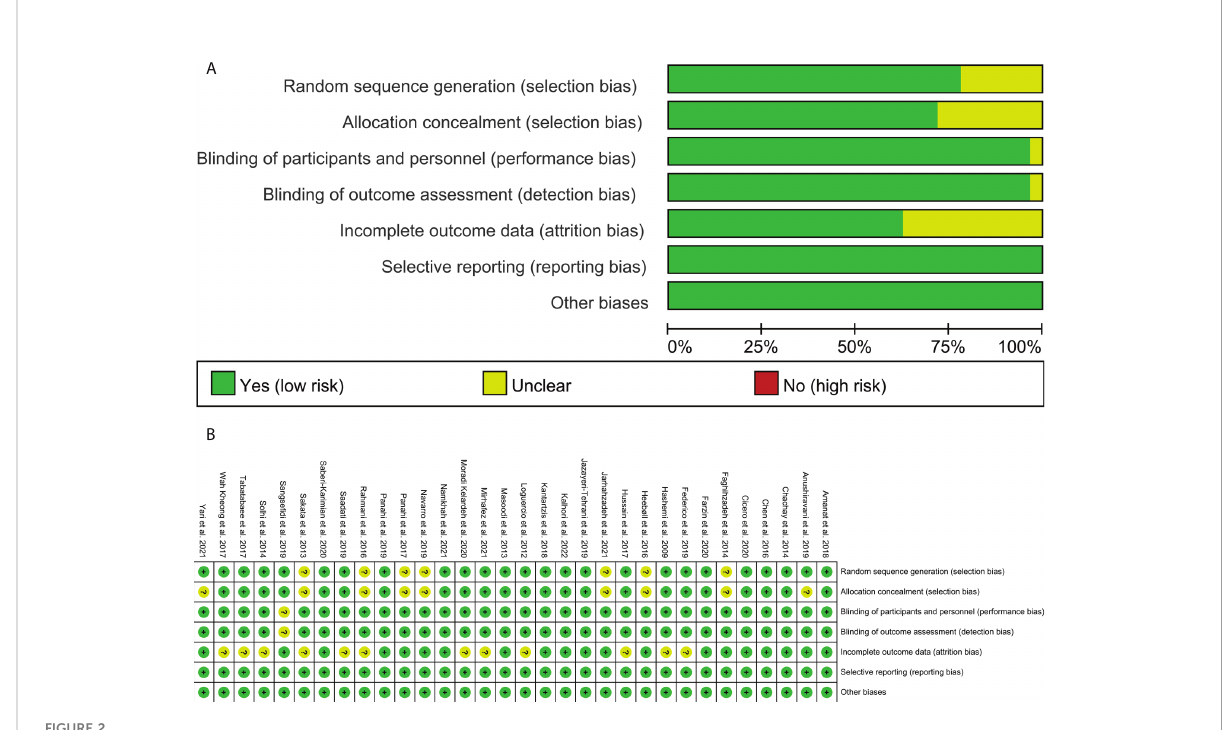
FIGURE 2 (A) Risk of bias graph; (B) Risk of bias